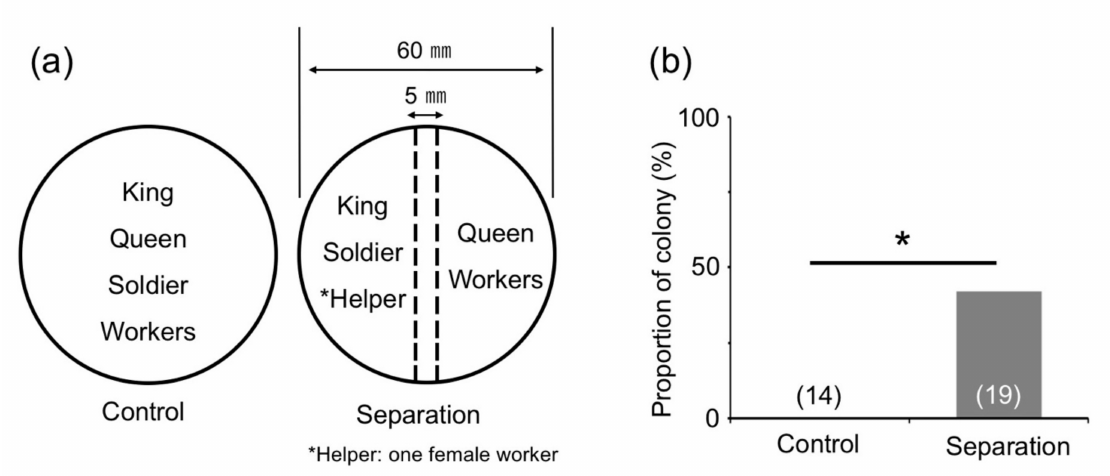
Figure 5. Effects of king-and-soldier separation on male reproductive soldier development. ( a ) Incipient colonies two months after the emergence of the first soldier were prepared for analysis. Broken lines indicate metal-wire mesh. ( b ) Male reproductive soldier development was only observed in the separation treatment. The numbers of colonies examined are indicated in parentheses. Asterisk denotes significant differences (Fisher’s exact test, * p < 0.05).